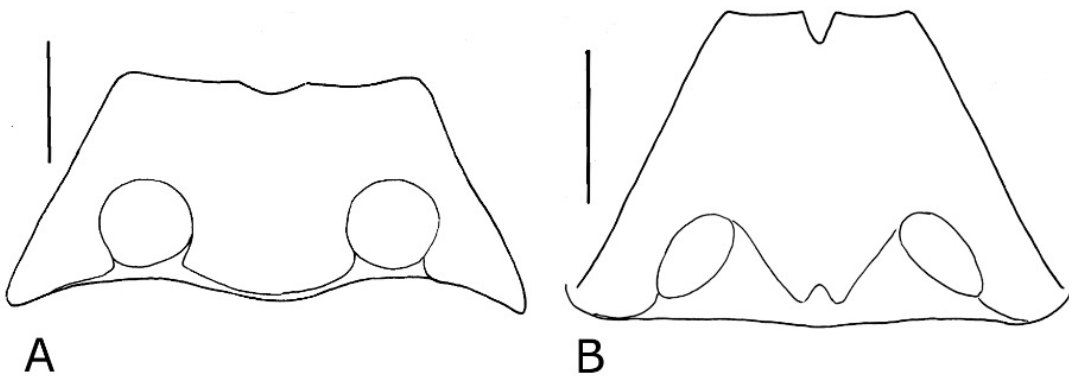
Figure 7. Sclerocardius africanus (Boheman): ( A ) tergite VII male, and ( B ) tergite VII female. Scale bars = 1